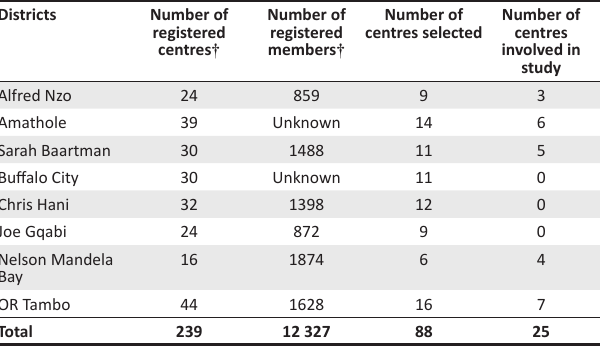
TABLE 1: Service centres for older persons in the Eastern Cape